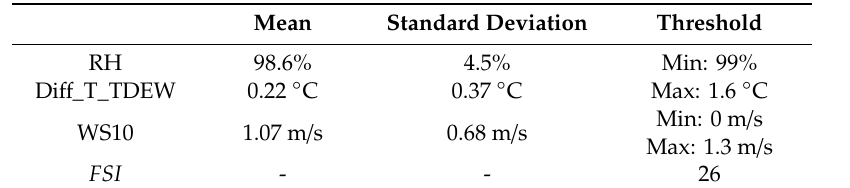
Table 7. Mean, standard deviation and thresholds selected for relative humidity, surface temperature / dew point depression and wind speed measured in fog condition and fog stability index ( FSI ) threshold calculated using Youden’s index for Milano Malpensa.